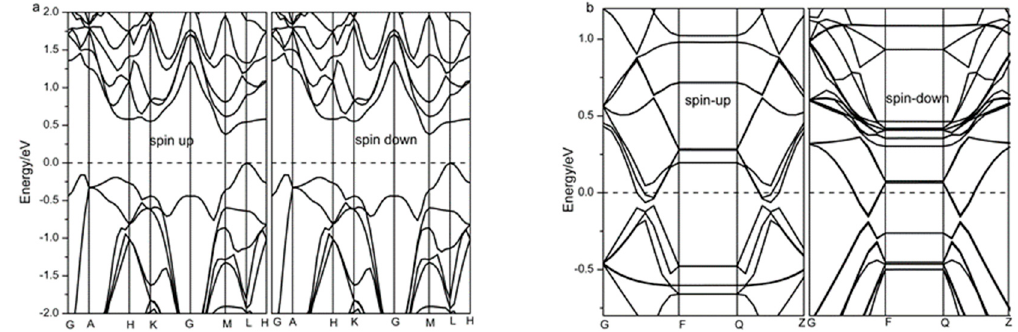
Figure 3. Band structure with spin-up and spin-down of ( a ) bulk and ( b ) monolayer CrSi 2 .